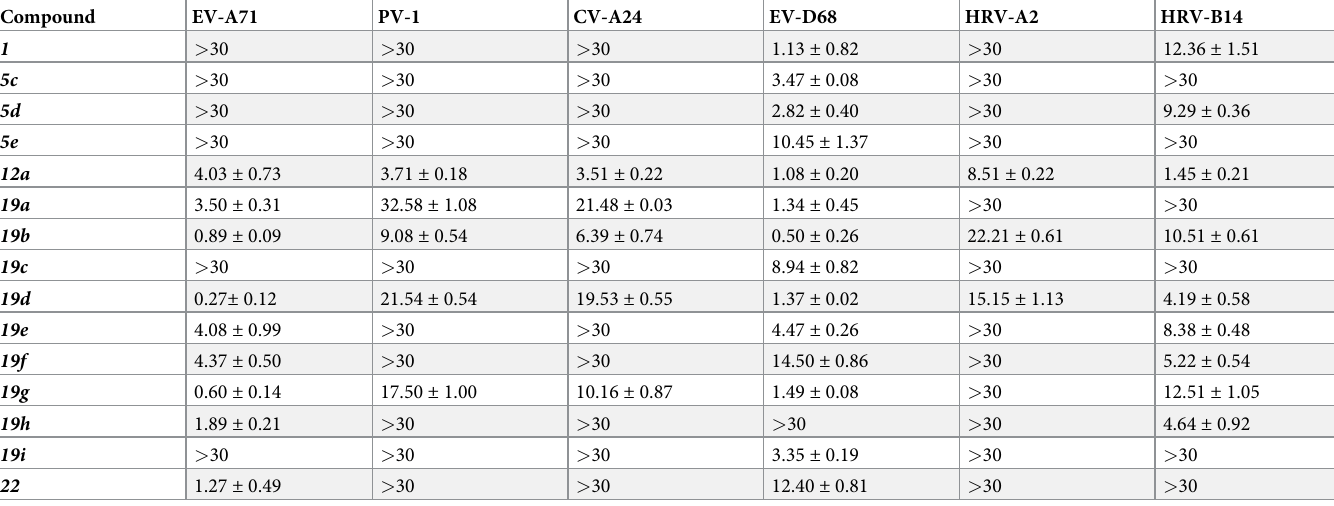
Table 2. Antiviral activity of active compounds against representative EV species.